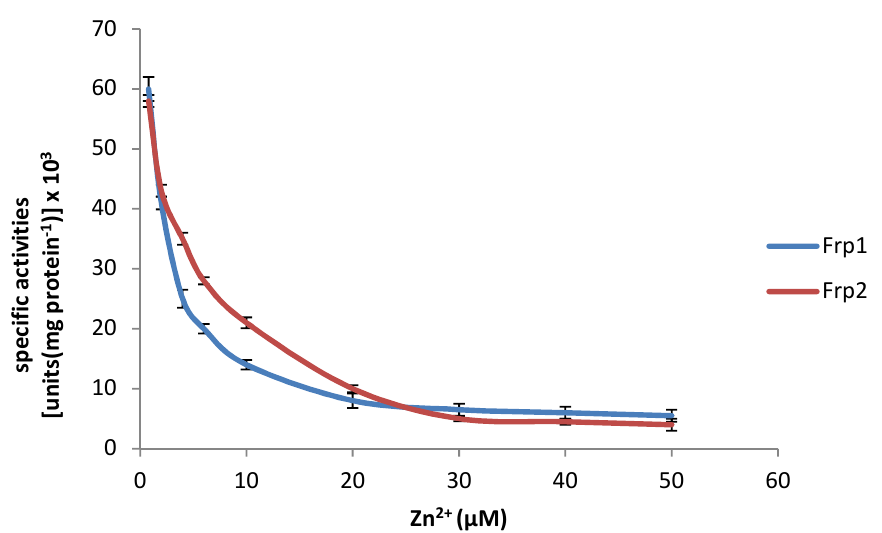
Figure 3. Activity of highly purified preparations of Frp1 and Frp2 in the presence of increasing levels of Zn 2+ .